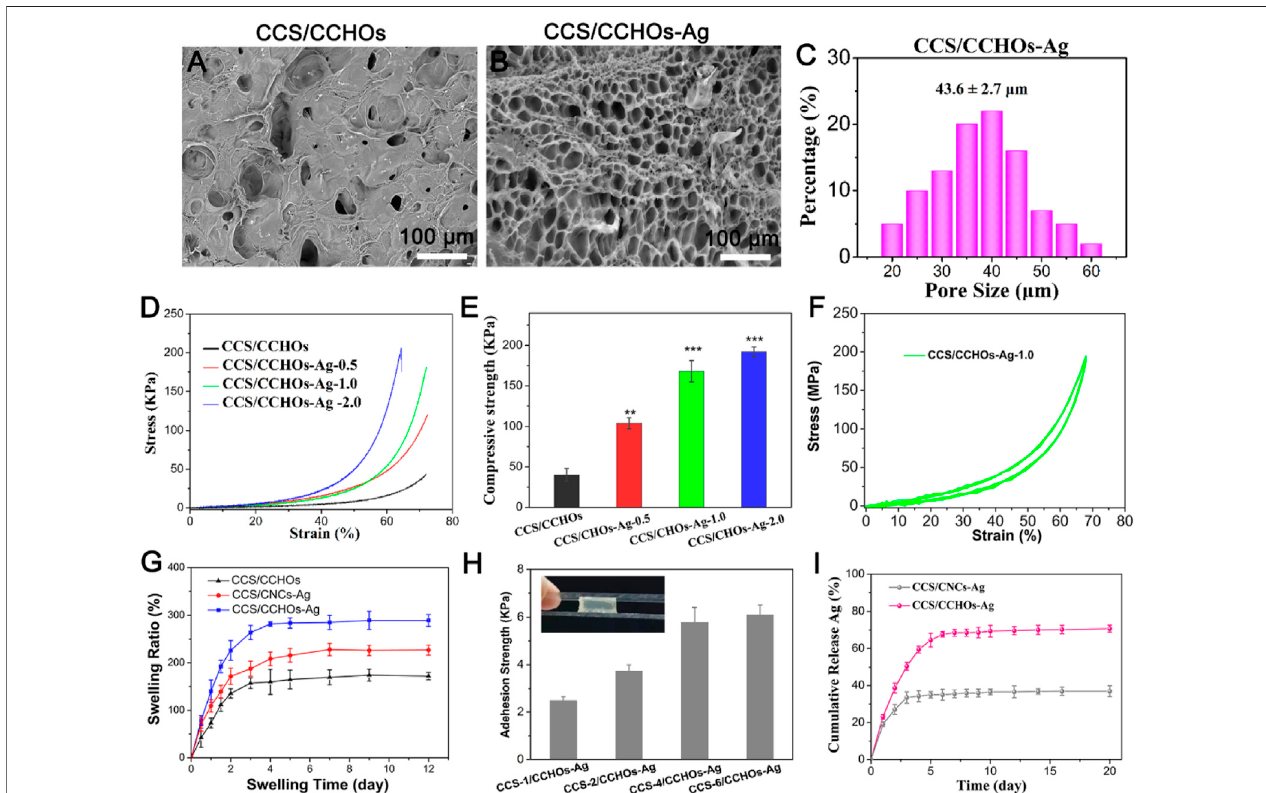
FIGURE 3| SEM images ofCCS/CHOs (A) and CCS/CHOs – Ag (B) , and statistical pore size of CCS/CHO-Ag hydrogel (C) . (D) Compressive stress – strain curves of Gel-DA/DOHA/DMON@Fe hydrogels with a molar ratio of 0.5, 1.0, and 2.0 for -CHO/-NH 2 and (E) its corresponding results of mechanical strength and Yong ’ s modulus. (F) In total, 20 successive compressive loading-unloading cycles for hydrogel with a strain of 70%. (G) Swelling rate. (H) Adhesion strength of hydrogels with different CCS content adhered to porcine skin. (I) In vitro release pro fi les of Ag + from the hydrogel